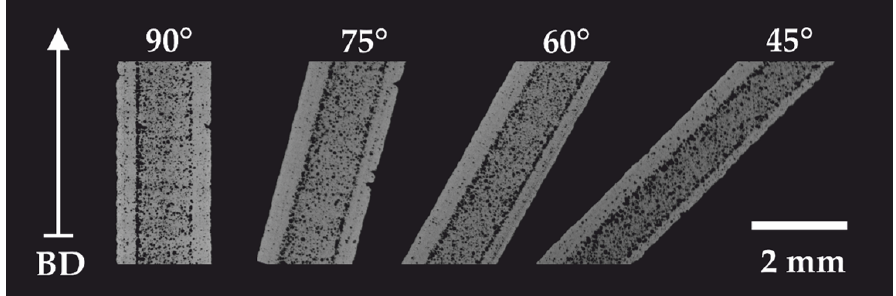
Figure 10. Projections of the minimum gray value give a qualitative overview regarding the distribu- tion of pores in each sample.